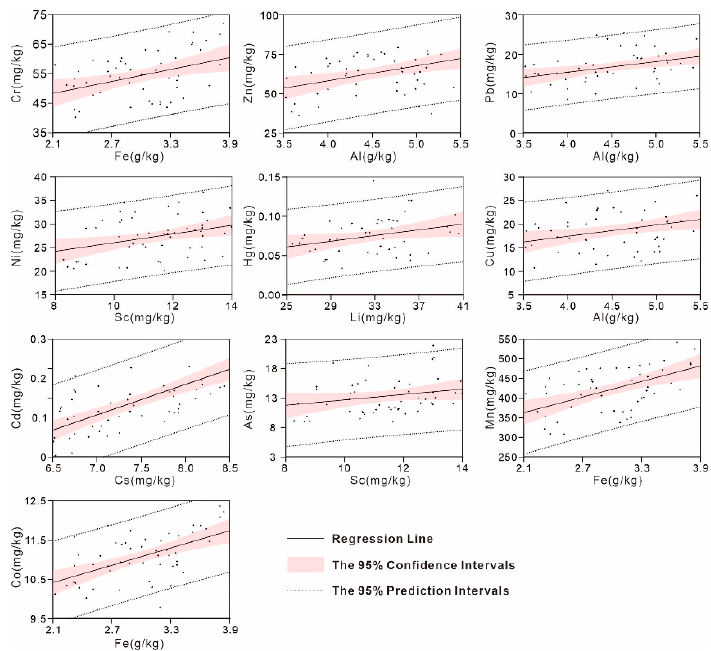
Figure 3. Linear regression analyses between the studied HMs and their optimal normalizers.